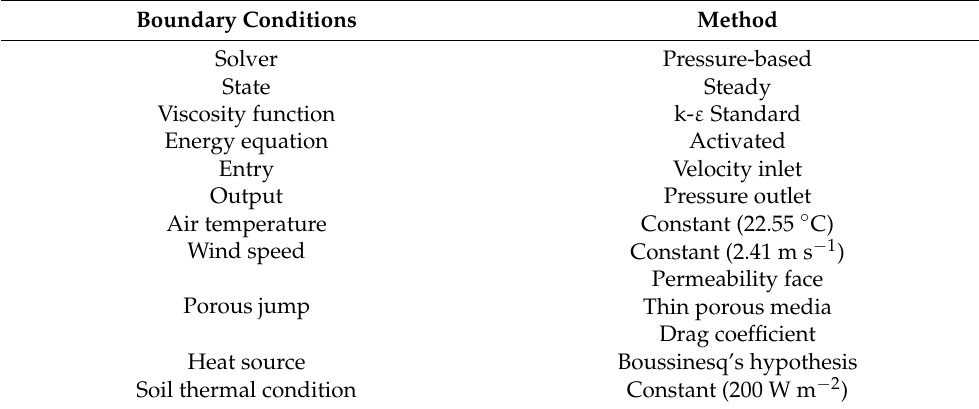
Table A1. Setting and boundary conditions of the CFD model.